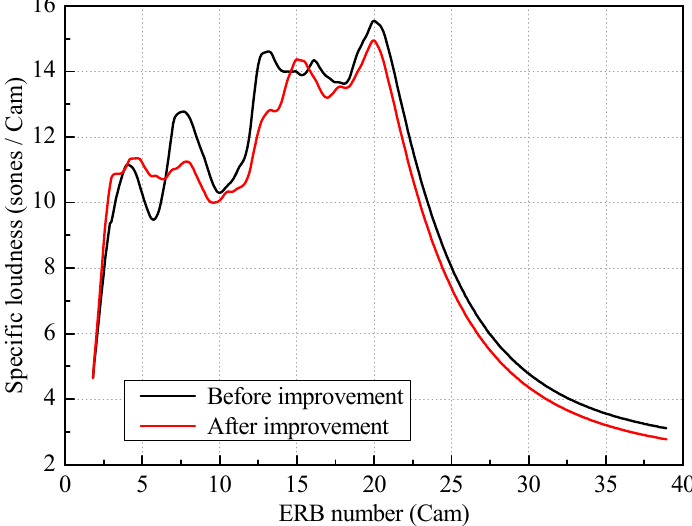
Figure 15. Specific loudness of sound field point near the oil sump before and after improvement.